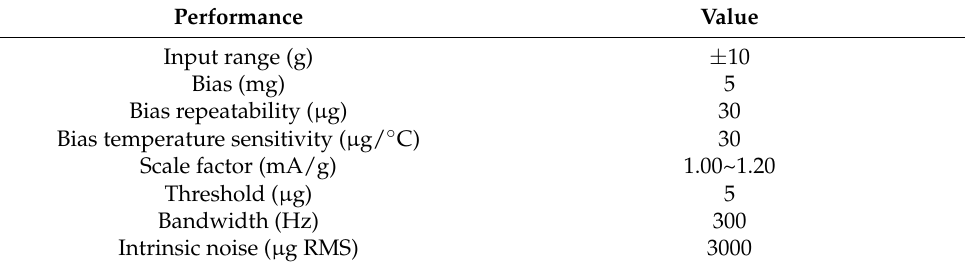
Table 2. Main performance characteristics of typical